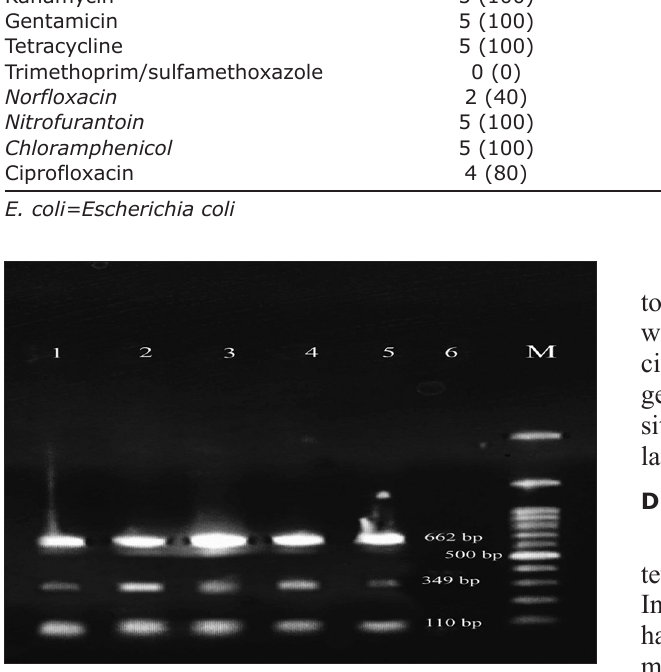
Figure-1: Gel picture is showing multiplex polymerase chain reaction-amplified products. M, 100-bp DNA marker; lane 1-6, 16S RNA Escherichia coli , stx1 , and stx2 positive; lane 6, negative